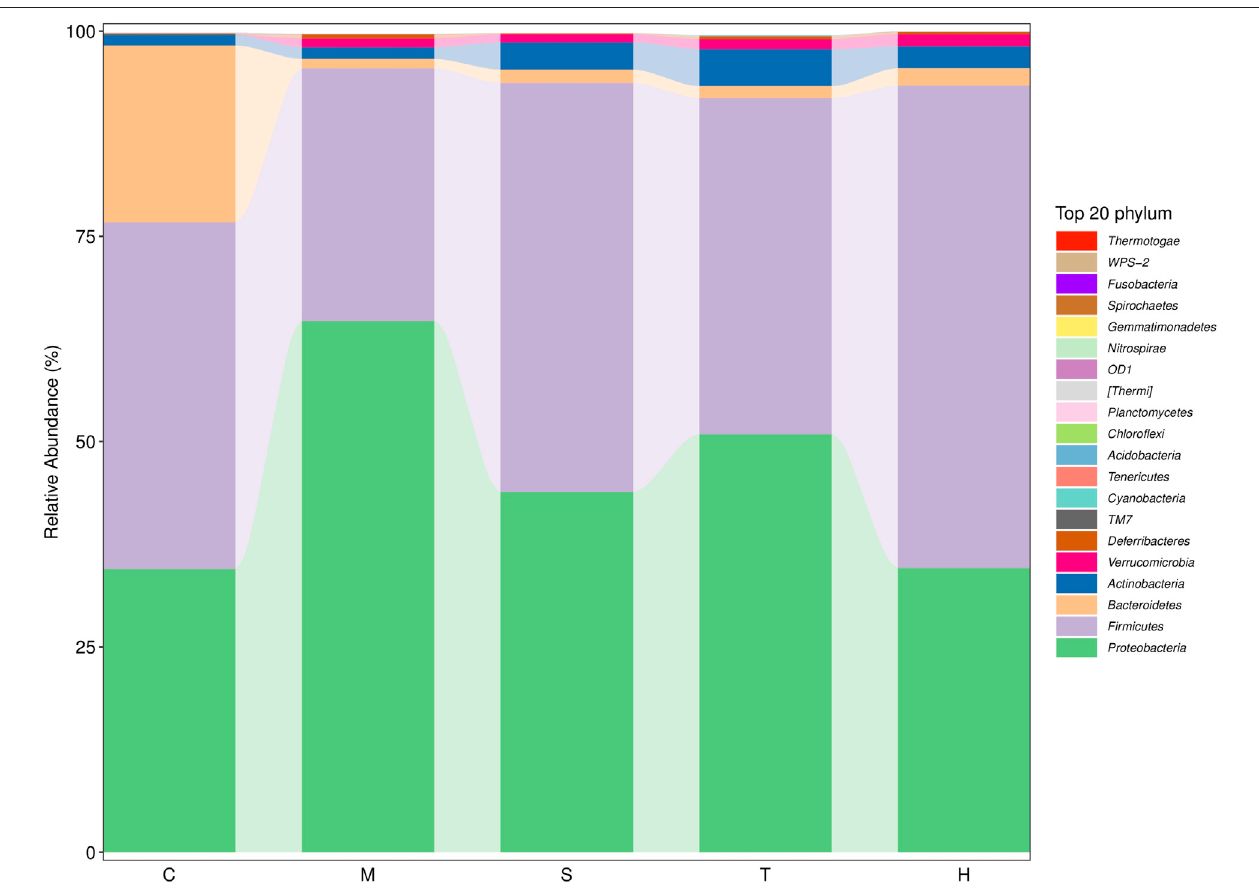
FIGURE4| Histogramofmeanvalueofintestinalmicro fl oraenrichmentinmiceatthephylumlevelineachgroup.C:control;M:model;S:salidroside;T:tyrosol;H: hydroxytyrosol.